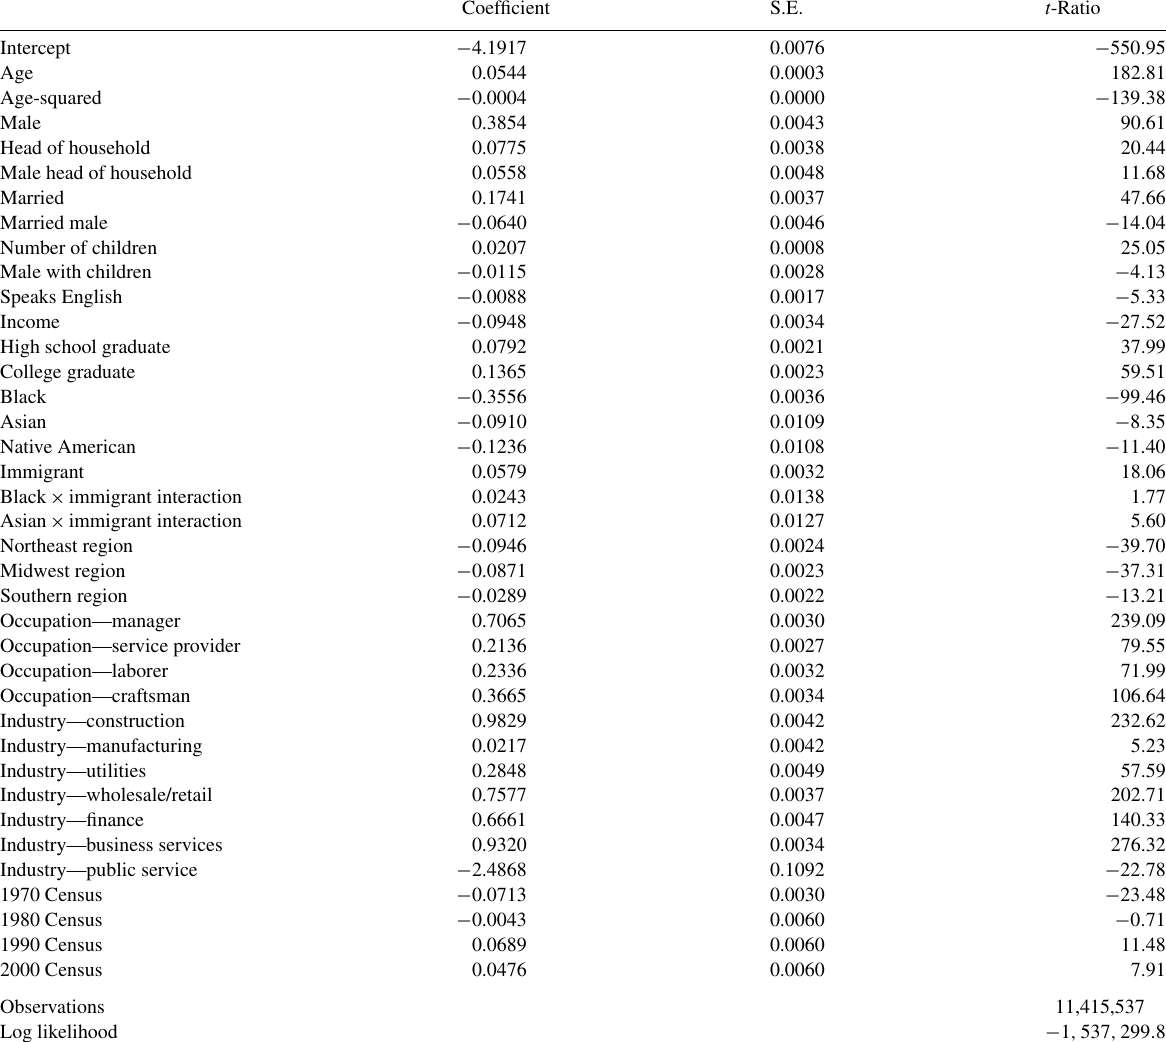
Table 9 Coefficients from the probit self-employment equation: 1960–2000